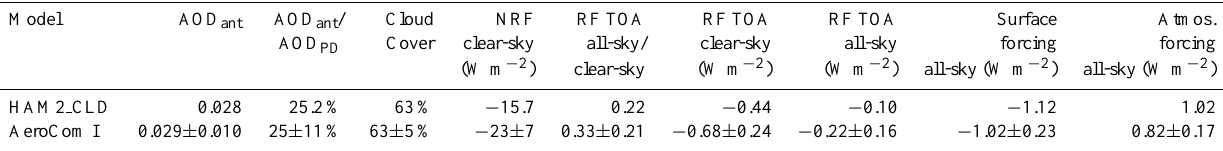
Table 9. Radiative properties and direct shortwave forcing of anthropogenic aerosols in HAM2, following Schulz et al. (2006). AOD ant and AOD ant /AOD PD are the anthropogenic AOD and its contribution to the present-day total AOD. RF stands for radiative forcing. NRF is the normalized radiative forcing per unit AOD. TOA stands for top-of-atmosphere. The AeroCom I multi-model mean and standard deviation are from Schulz et al. (2006). Further details can be found in Sect. 5.5.